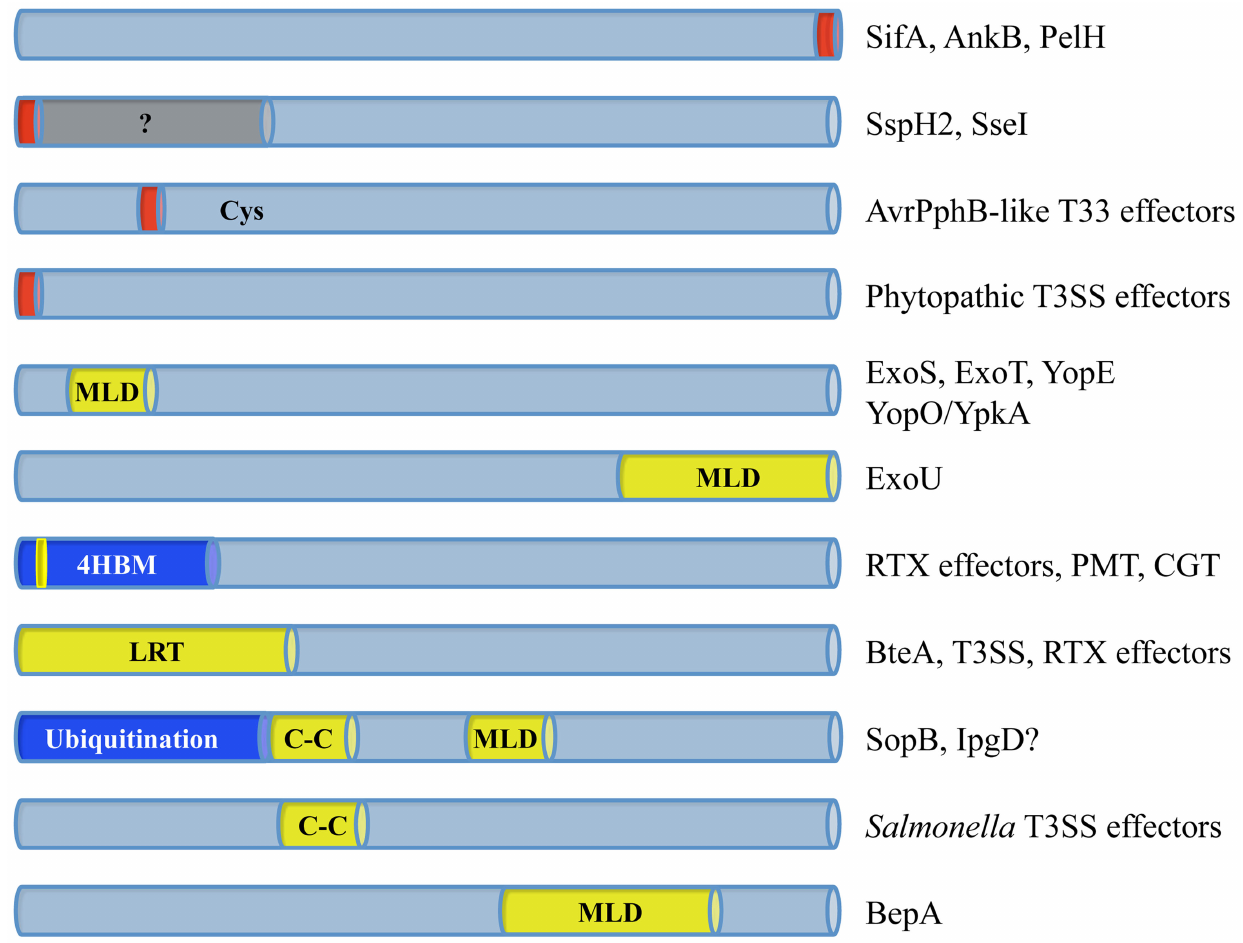
FIGURE 2 | Plasma membrane targeting motifs are not restricted to specific locations within the various effectors. The dedicated membrane localization domains (MLD) that have been identified are found at both termini and in the interior of their effectors. Many of these MLDs contain stretches of Ile/Leu/Val residues (yellow) to mediate hydrophobic membrane associations. In addition, regions rich in basic residues (dark blue) can enhance membrane